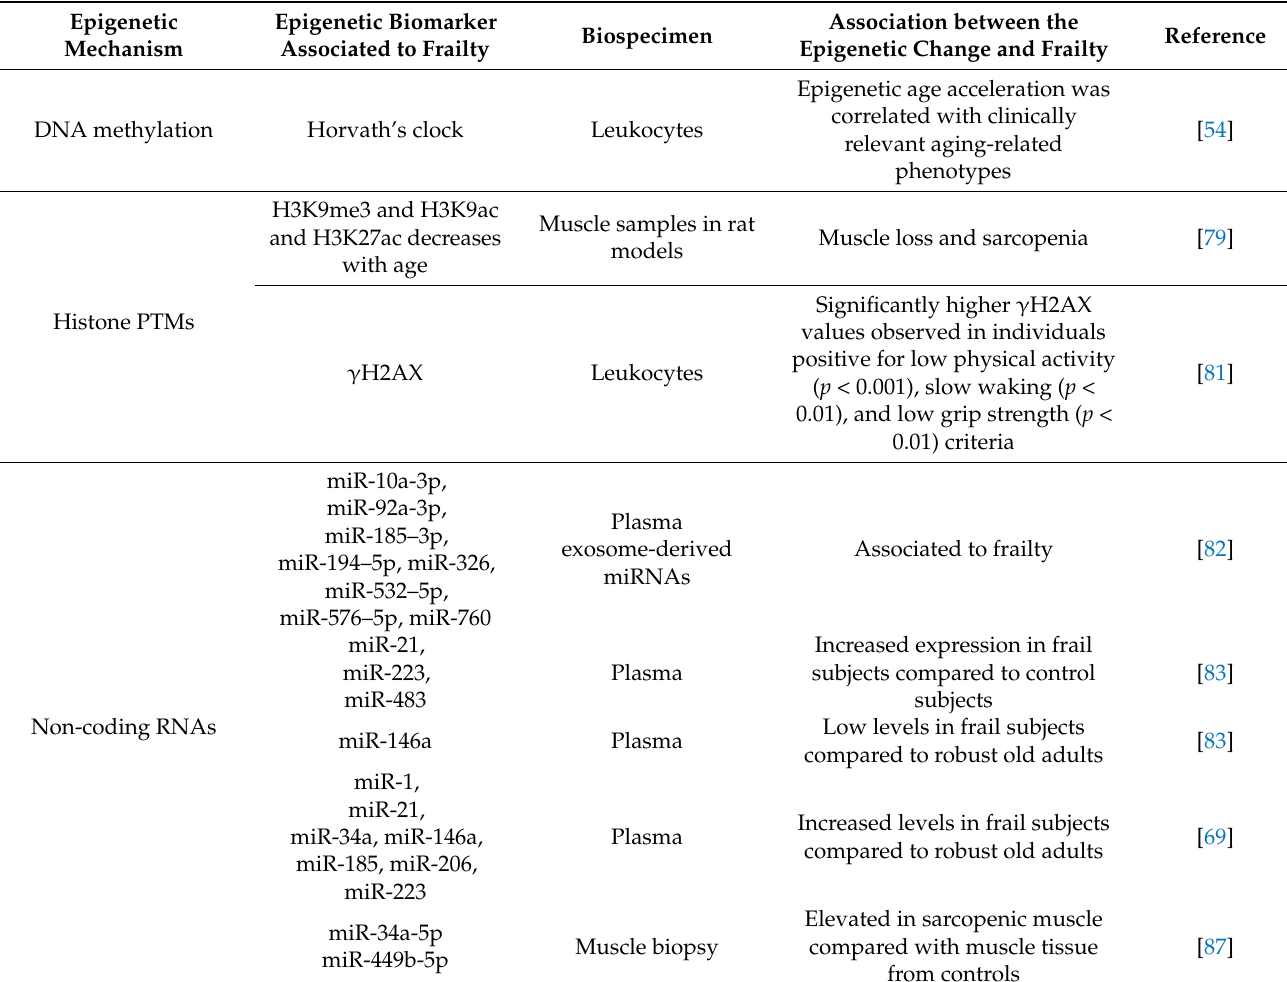
Table 1. Epigenetic biomarkers to study frailty-related